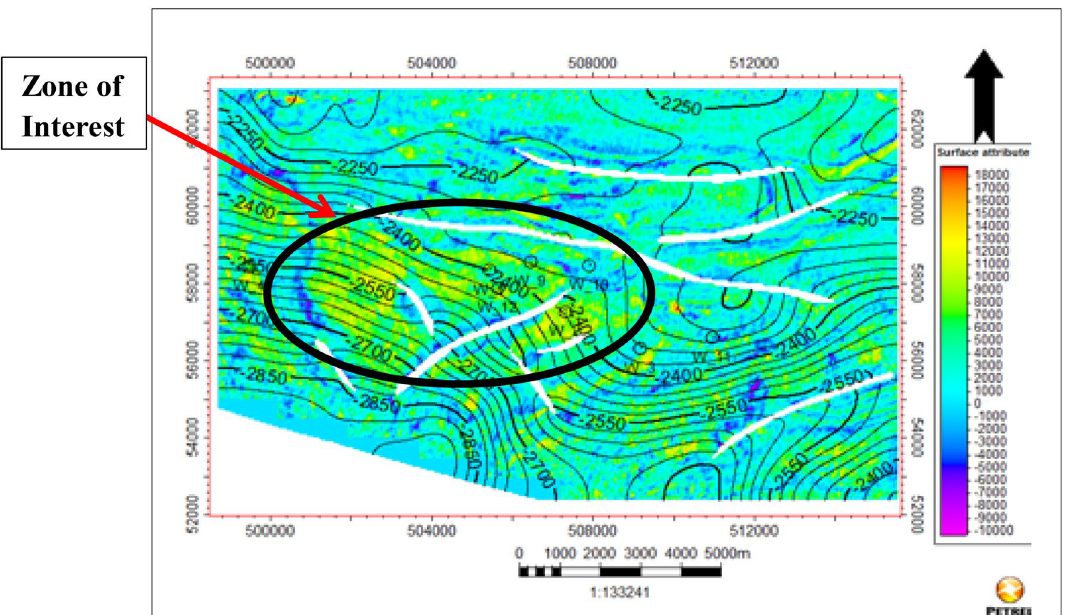
Fig. 10 Maximum amplitude attribute extracted on horizon